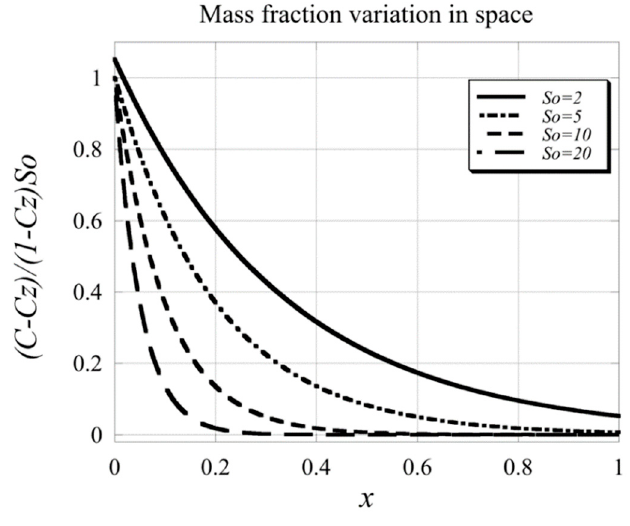
Figure 5. Graphical profile of the solution for the basic mass fraction for different Soret numbers. Substituting the solution for the mass fraction (64) and for the temperature (40) into Equation (35) leads to: